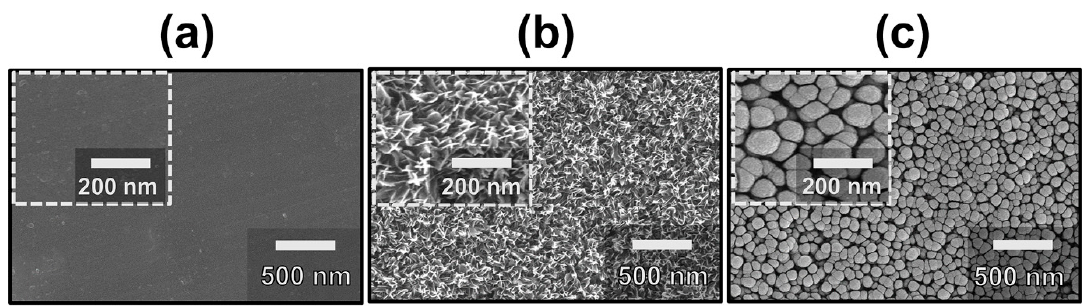
Figure 2. The FE-SEM images of surface morphologies: ( a ) Bare-Al; ( b ) WAO-Al; and ( c ) DE-Al.